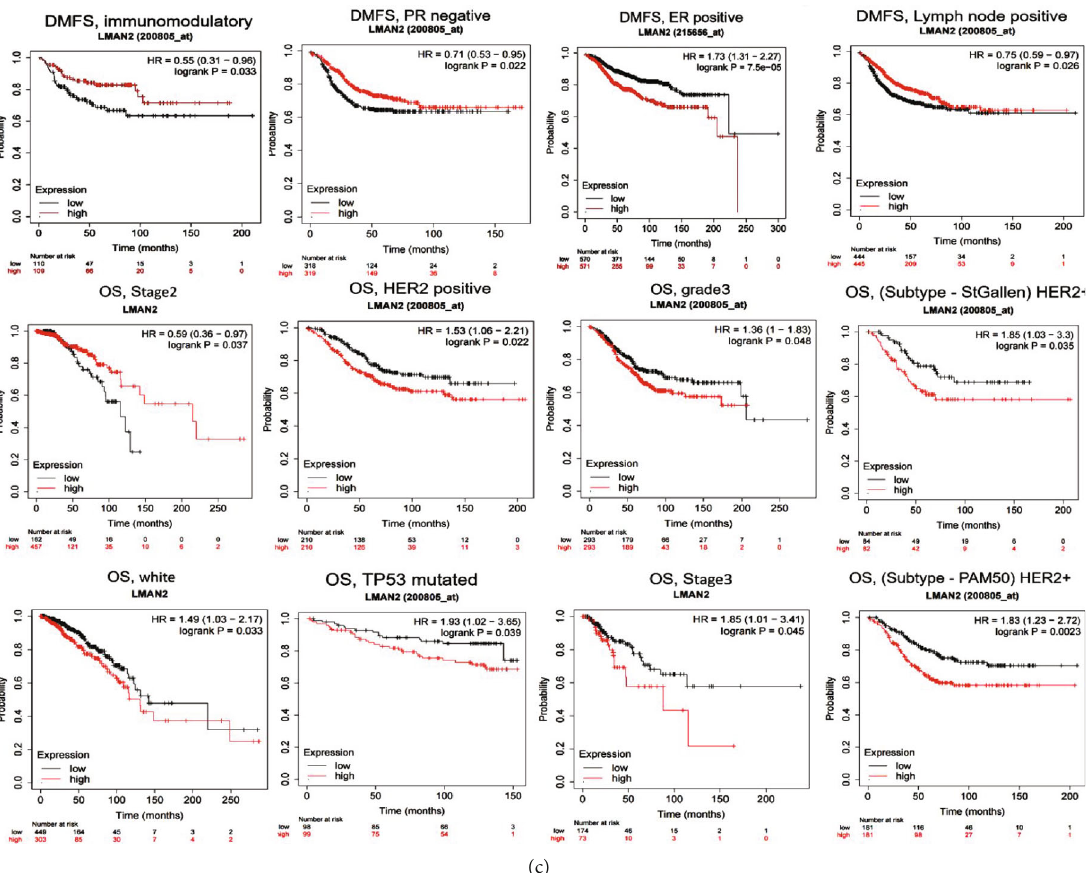
Figure 3: An elevated expression level of LMAN2 in breast cancer is linked to an unfavorable prognosis. Correlation between LMAN2 gene expression with DMFS, RFS, prognosis, and disease-free survival (DFS) in breast cancer patients. The overexpression of LMAN2 was considerably linked to patient survival and resulted in adverse prognostic values. A p value < 0.05 represents a signi fi cant di ff erence between (a – c) LMAN2 gene and